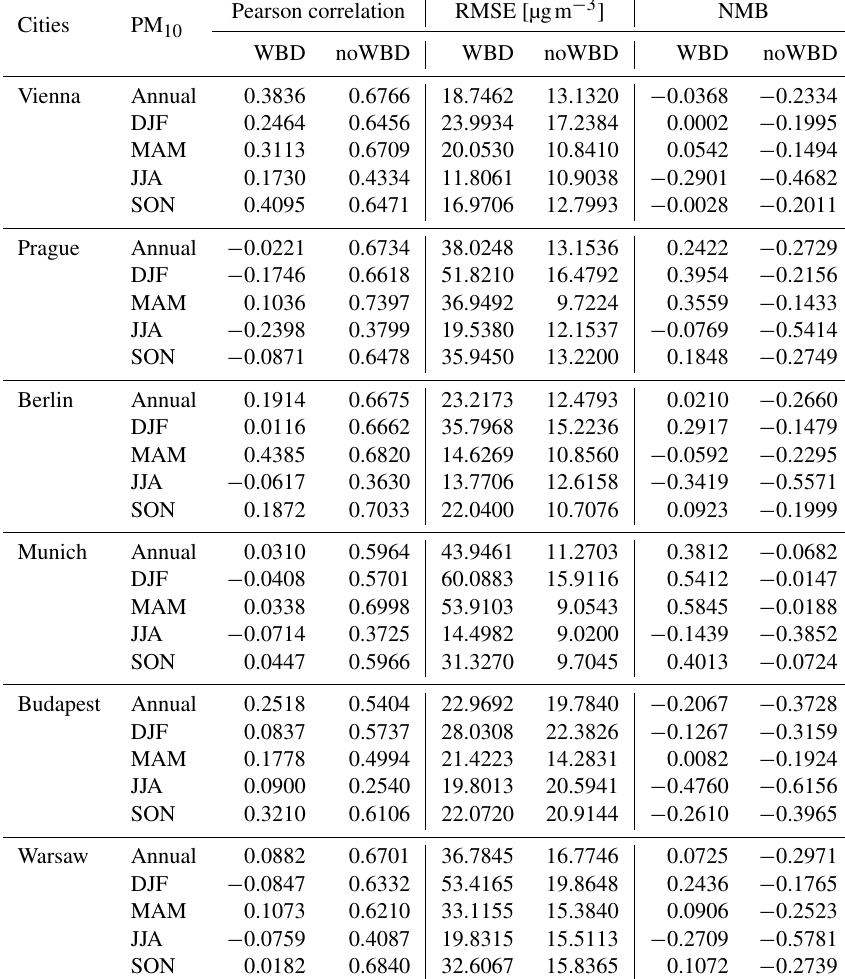
Table 2. Annual and seasonal statistical measures (Pearson correlation, RMSE, NMB) for PM 10 for both the WBD and noWBD ISORROPIA simulations calculated from the daily